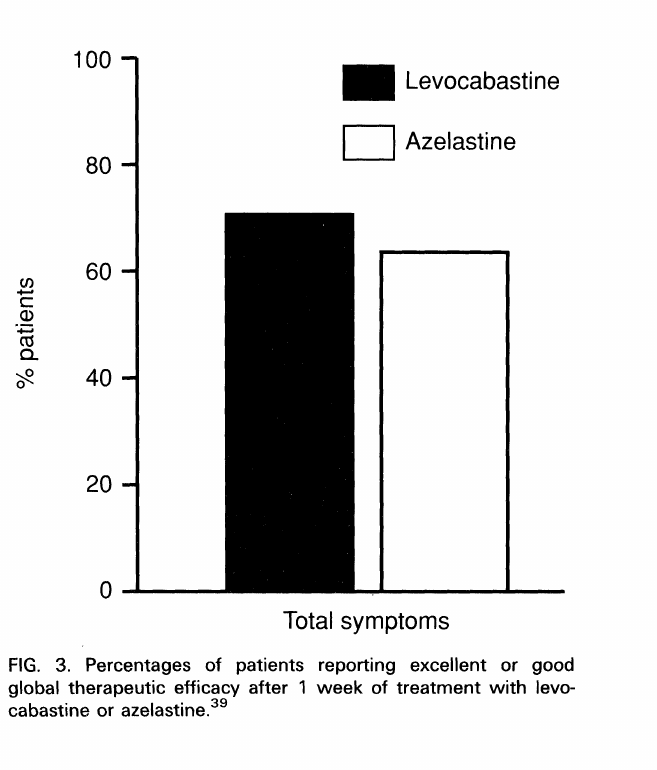
FIG. 3. Percentages of patients reporting excellent or good global therapeutic efficacy after week of treatment with levo- cabastine or azelastine.